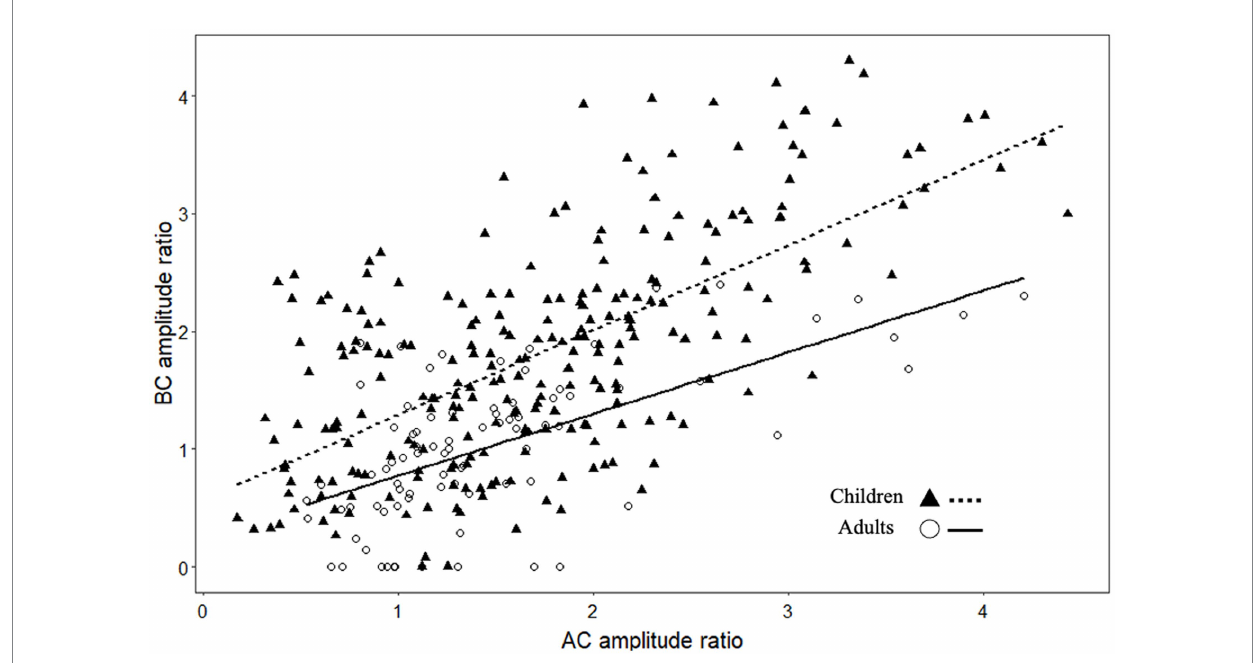
FIGURE 4 Scatterplot showing the relationship between c-VEMP amplitude ratios (P-N peak to peak amplitude/EMG amplitude) measured with air conduction (AC) and bone conduction (BC) stimulation.